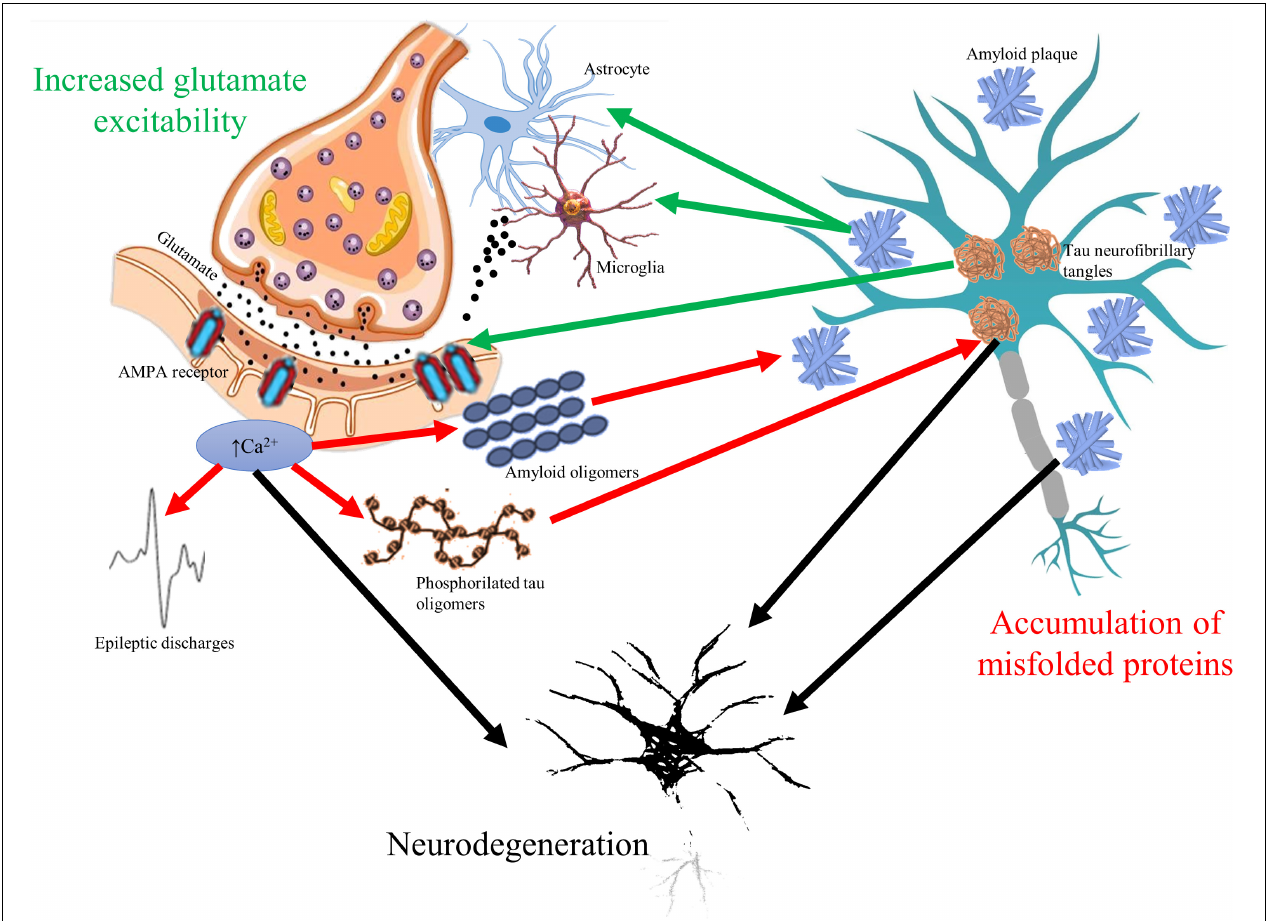
FIGURE 1 | The vicious circle of glutamate mediated hyperexcitability and accumulation of misfolded toxic proteins in cognitive disorders. Glutamate neurotransmitter is altered in all cognitive disorders resulting in overexpression of α -amino-3-hydroxy-5-methyl-4-isoxazolepropionic acid (AMPA) receptors and elevated intracellular calcium signaling. Elevated calcium signal associates to higher release of amyloid oligomers to extracellular space and to increased phosphorylation of tau oligomers (red arrows). Increased firing of neurons represented by epileptic discharges is a consequence of glutamate-related hyperexcitability as well. On the other hand, accumulation of amyloid plaques and tau neurofibrils change glutamate receptor expression and induce excessive release of glutamate from microglial cells and astrocytes (green arrows). The bidirectional pathologic relationship could result in progressive neurodegeneration (black arrows), which is common hallmark of cognitive